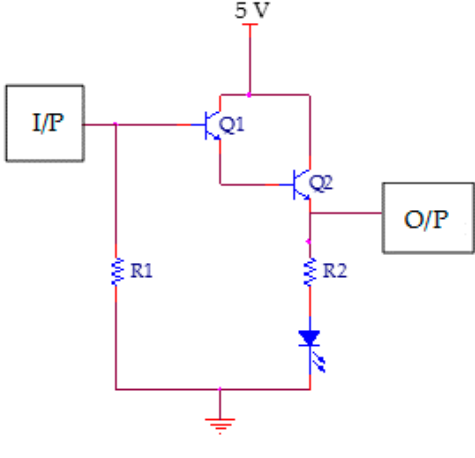
Figure 2. Amplifier cell schematic.